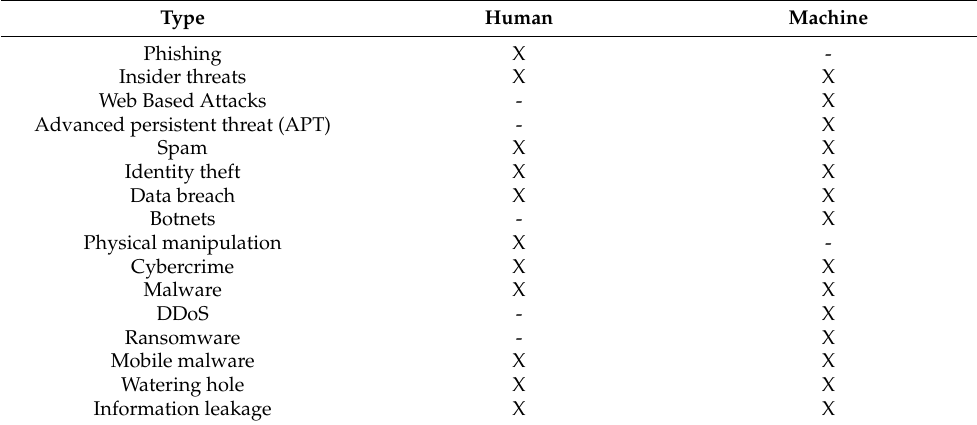
Table 5. Attacks adversary’s targets (machine or